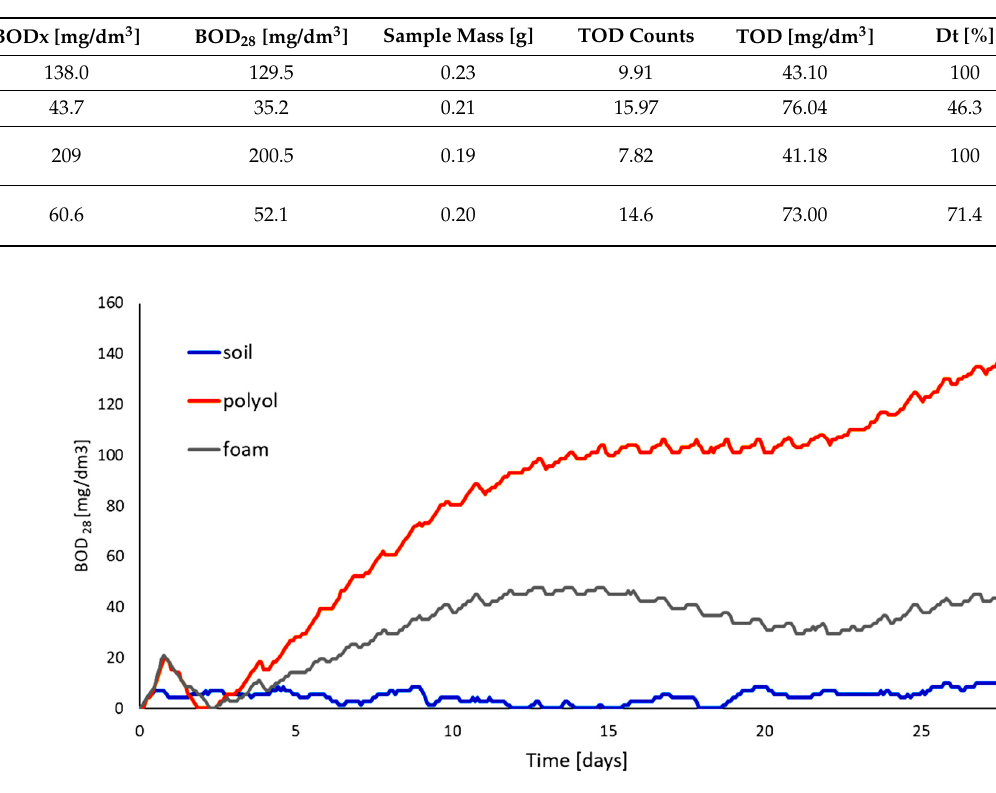
Table 12. Results of susceptibility to biodegradation of polyol and foam (BOD soil —8.5 mg/dm 3 ).